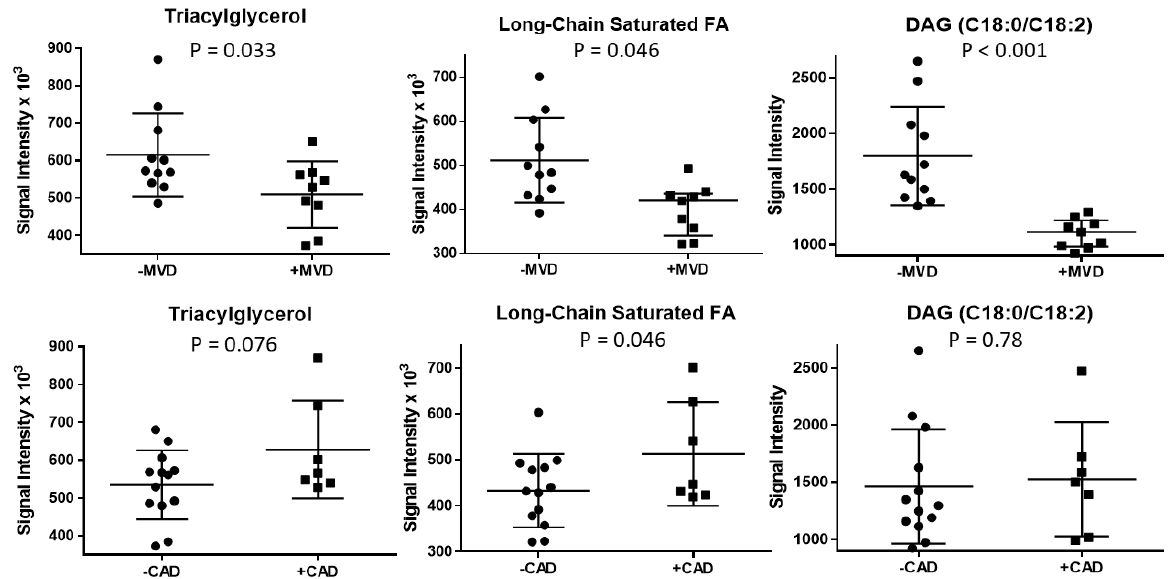
Figure 3. Abundance of triacylglycerol, long-chain saturated fatty acids, and diacylglycerol containing stearic and linoleic acid (DAG C18:0/C18:2) in plasma of participants stratified according to presence or absence of microvascular dysfunction (MVD) (top panels), or according to presence of non-obstructive coronary artery disease (CAD) (bottom panels). Data from all subjects are shown. Table 6. Best classifying plasma lipidomic species for microvascular dysfunction (MVD) *.